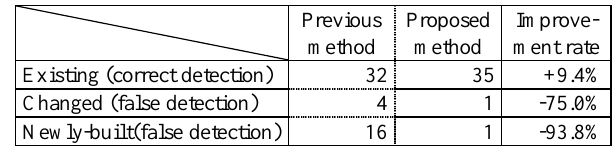
Table 3. Result assessment of previous and proposed